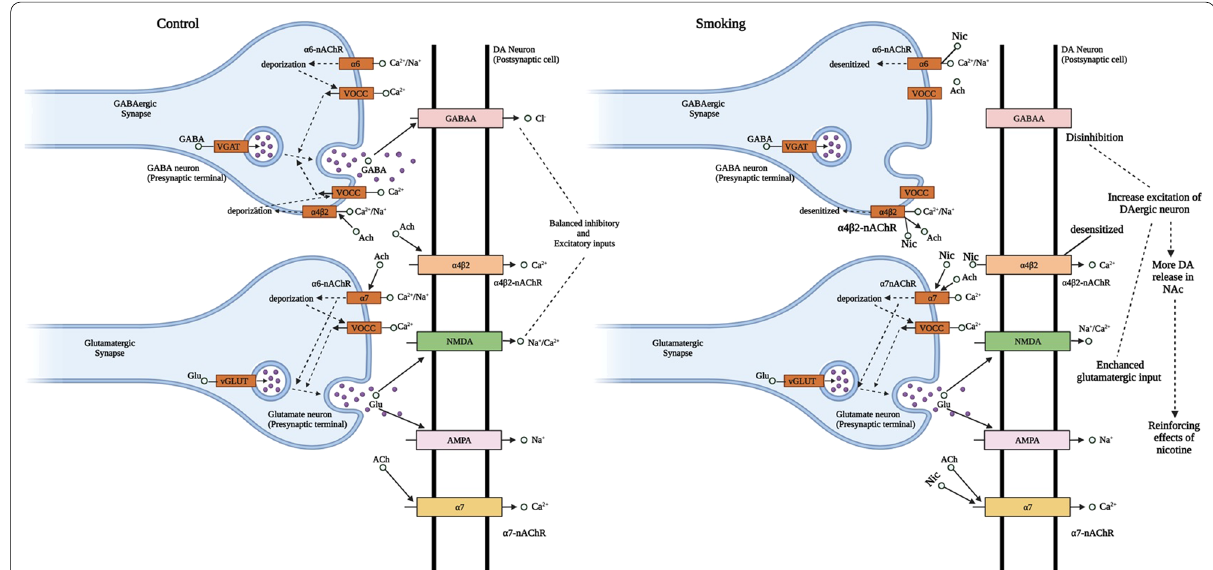
Fig. 4 Signalling pathway related to nicotine addiction: Nicotine is a substance contained in tobacco, and most smokers are addicted to nicotine; therefore, they use tobacco on a regular basis. It is an addictive drug that can harm your lungs if you smoke tobacco. The mu opioid receptor (OPRM1) ASN40ASP functional variant has been associated with response to NRT, but the direction of association in different populations has not been consistent. Nicotine also increases the levels of endogenous opioids that bind to mu opioid receptors on GABA interneurons in the VTA